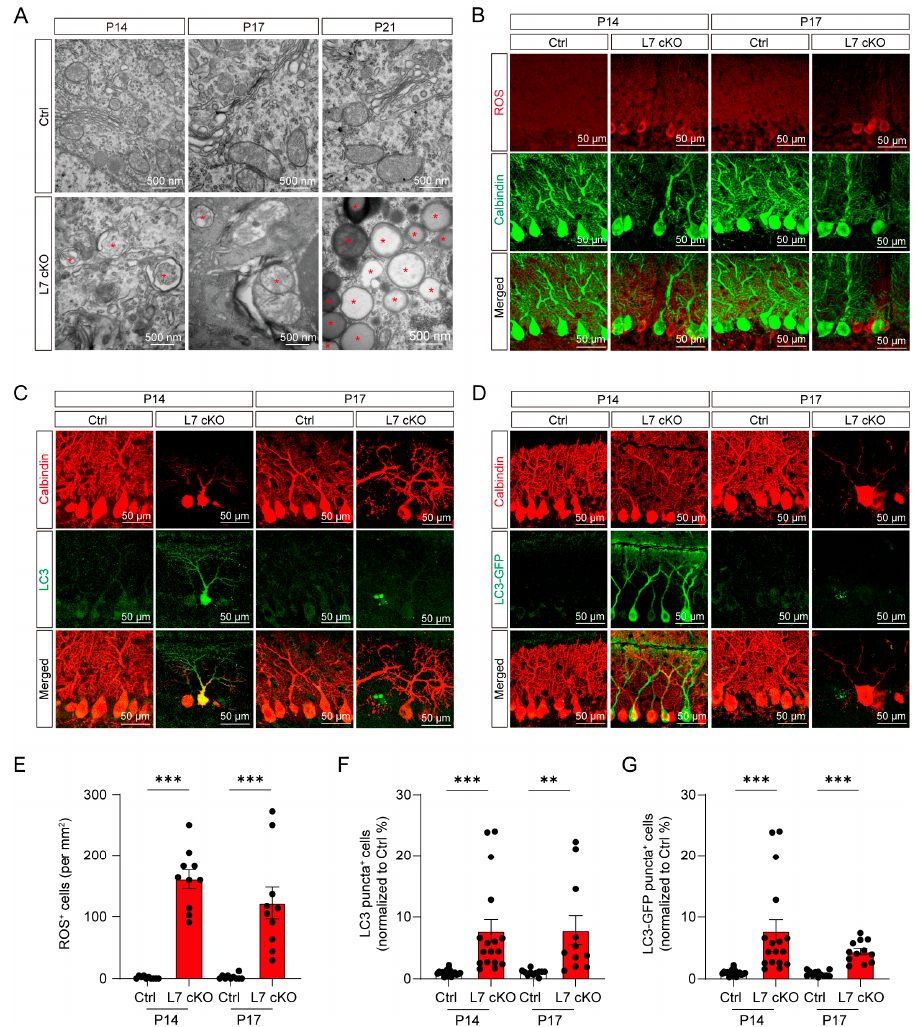
Figure 5. Mitochondrial damage with ROS and LC3 accumulation in OGT-deficient PCs. ( A ) Electron micrographs of PCs from the Ctrl and cKO mice at P14, P17 and P21, respectively. Autophago- some-like structures (labeled with asterisks) in PCs are labeled (scale bar: 500 nm) . ( B ) The fl uores- cence plots show that ROS (red) were signi fi cantly elevated in the PL (scale bar: 50 µm). ( C ) Co- immuno fl uorescent staining with anti-LC3 and anti-calbindin antibodies showing the signi fi cantly increased LC3 expression (scale bar: 50 µm). ( D ) Immuno fl uorescence analysis of the cellular local- ization of LC3 (green) and immuno fl uorescent staining with anti-calbindin antibody (red) (scale bar: 50 µm). ( E ) Quanti fi cation of the ROS fl uorescence intensity of the PL from the Ctrl and cKO mice (mean ± SEM; *** p < 0.001, n = 10). ( F ) Quanti fi cation of the LC3 puncta-positive cells from the Ctrl and cKO mice at P14 and P17 (mean ± SEM; *** p < 0.001, ** p < 0.01, n > 10). ( G ) Quanti fi cation of LC3 puncta-positive cells among PCs from the Ctrl and cKO mice at P14 and P17 (mean ± SEM; *** p < 0.001, n > 10).